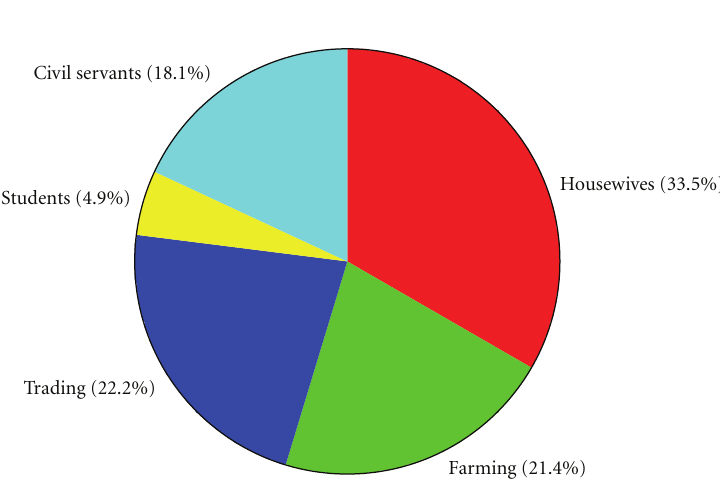
Figure 1: Shows occupational status of the patients. Table 2: Shows comparison of baseline characteristics of survivors and nonsurvivors of hypertension